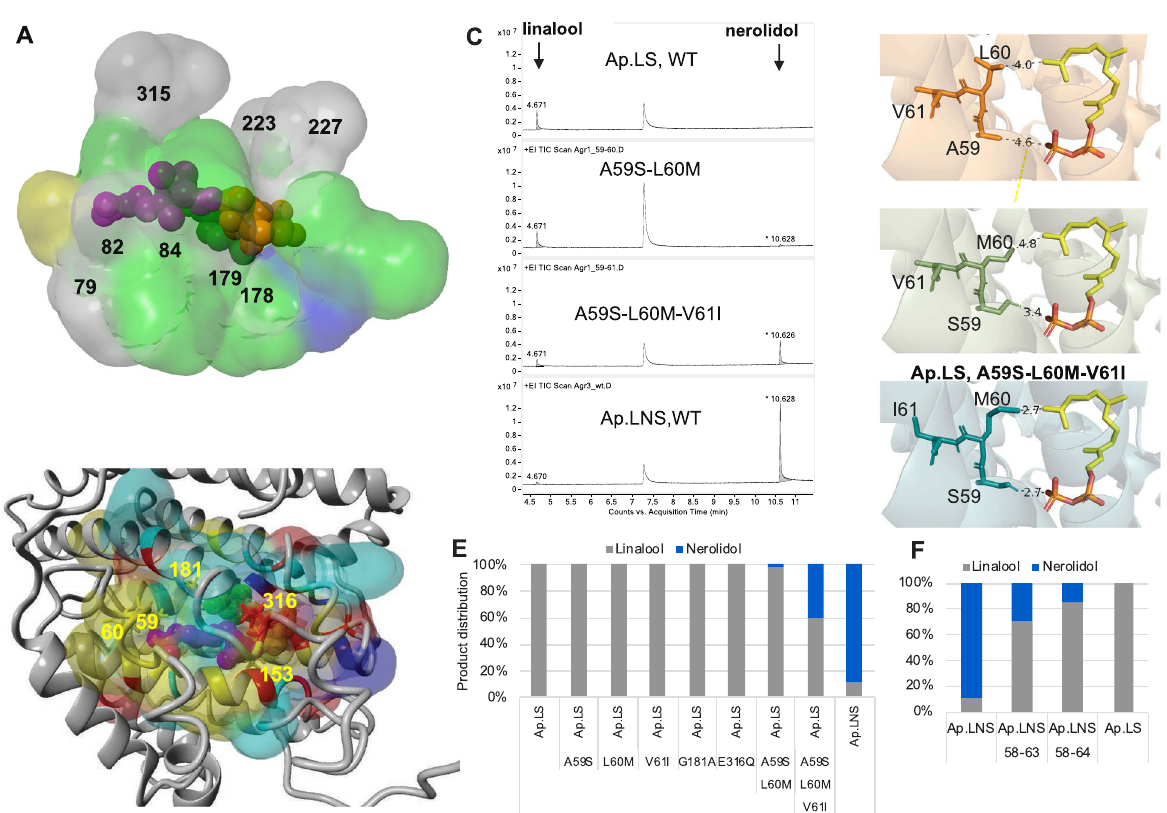
Fig. 7 Structure analysis for the understanding of activity and speci fi city. A The aligned 3D active site surfaces of Ap.LS, Sc.LNS, and Ma.LS. The residues are listed in Supplementary Table S4. Gray: conserved residues among the linalool synthases of three kingdoms; green: not conserved in plant linalool synthase; blue: not conserved in bacterial linalool synthase; yellow: not conserved in fungal linalool synthase. B Highlight of the key residue difference between Ap.LS and Ap.LNS. Detailed comparison of binding-pocket residues in Supplementary Table S5. C Mutation of the key residues responsible for Ap. LS speci fi city. D The interactions of the selected residues with FPP in Ap.LS wild type (WT) and its mutants (distance by dash line, unit: Å). E Quantitative comparison of Ap.LS and its mutants. F Quantitative comparison of Ap.LNS and its